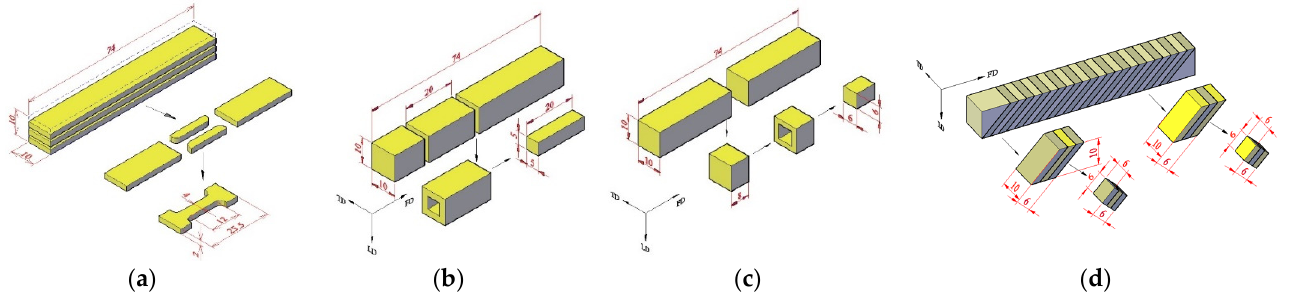
Figure 2. Specimen extraction for ( a ) tension tests, ( b ) shear tests and compression tests ( c ) for a piece with homogeneous deformation and ( d ) for a piece with periodic shear banding.